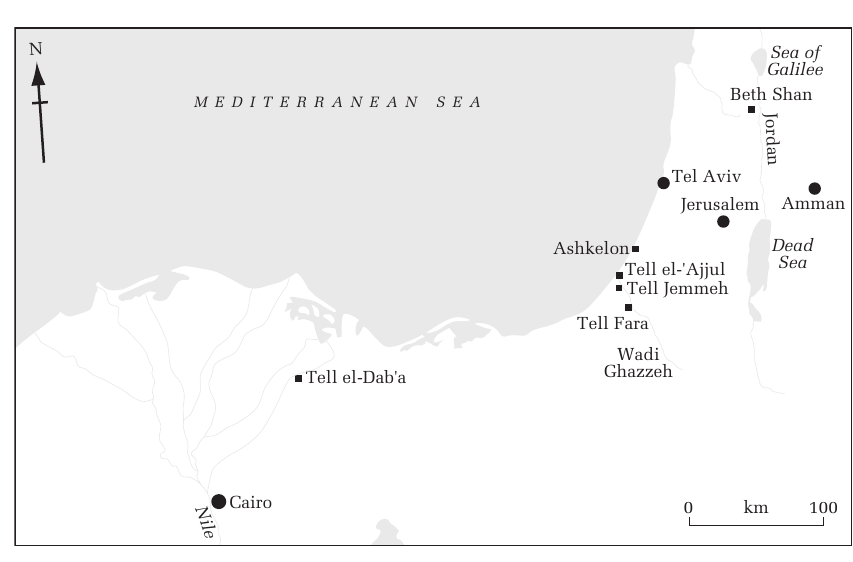
Figure 1 The Levant and the Nile delta, showing the location of the ancient sites men- tioned in the